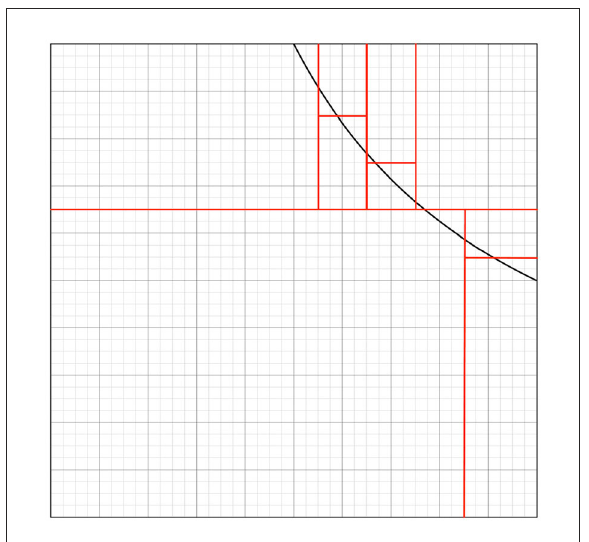
FIGURE4 Class separation line o × c > 0.5 (black) and separation planes of an approximating decision tree